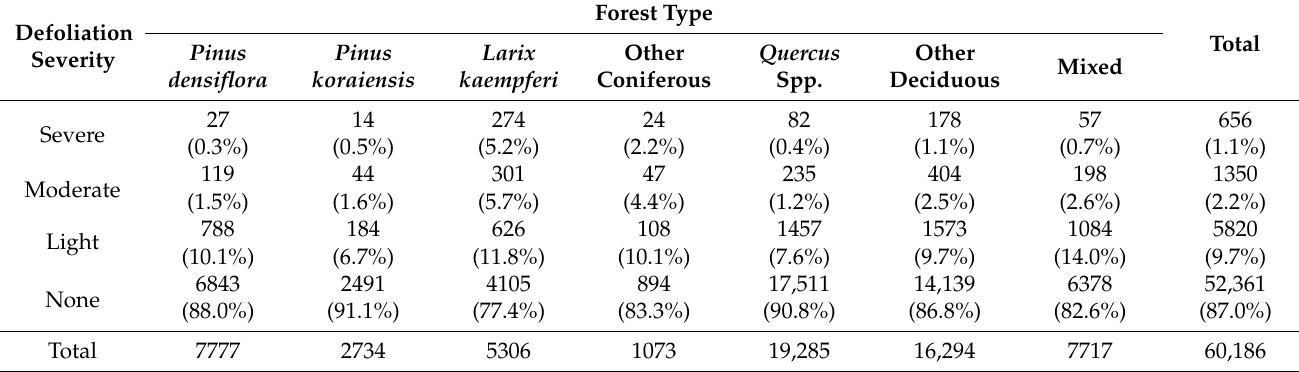
Figure 2. Landsat-based gypsy moth defoliation maps in Wonju and the surrounding area in 2020. Mapped results represent the mean reduction in Normalized Difference Moisture Index (NDMI) scores calculated using all the available observations in June from 2017 to 2019. Table 1. Area defoliated by gypsy moth at Wonju in 2020 according to the defoliation severity and forest type. The areas were estimated based on the reduction in NDMI in 2020 compared to the prior 3